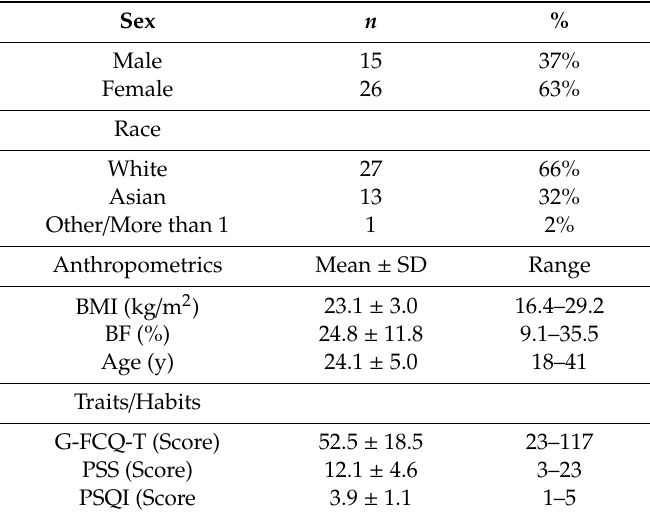
Table 2. Anthropometric and demographic summary.